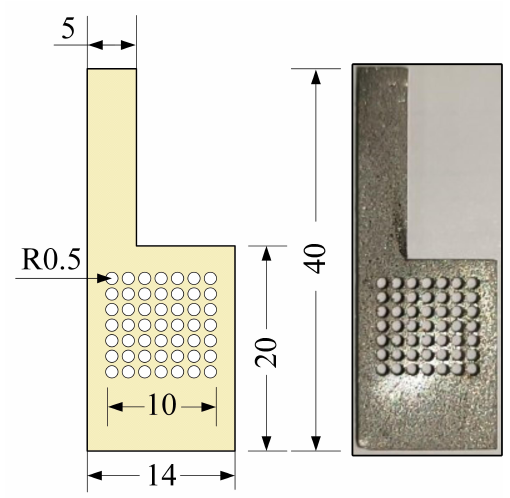
Figure 2. The CCC in